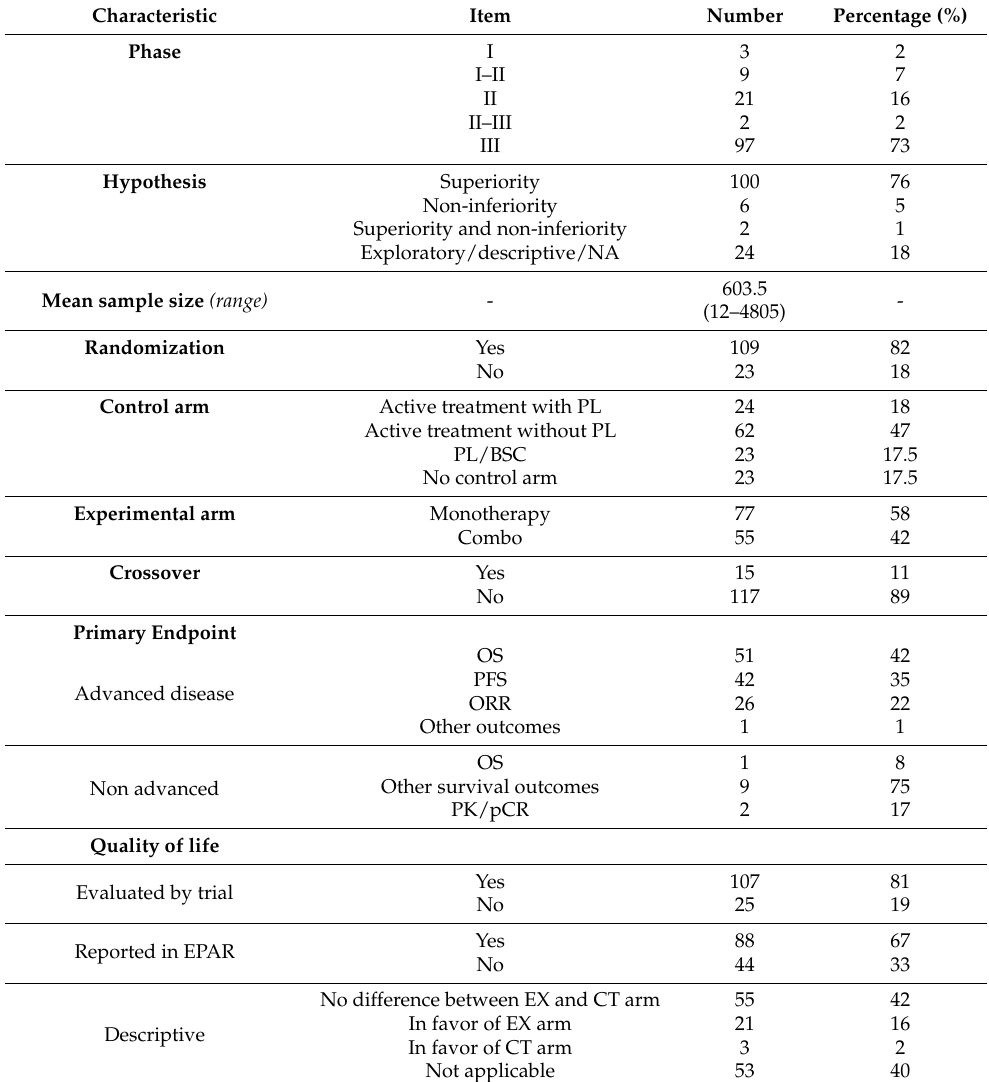
Table 3. Features of clinical trials leading to oncologic drug